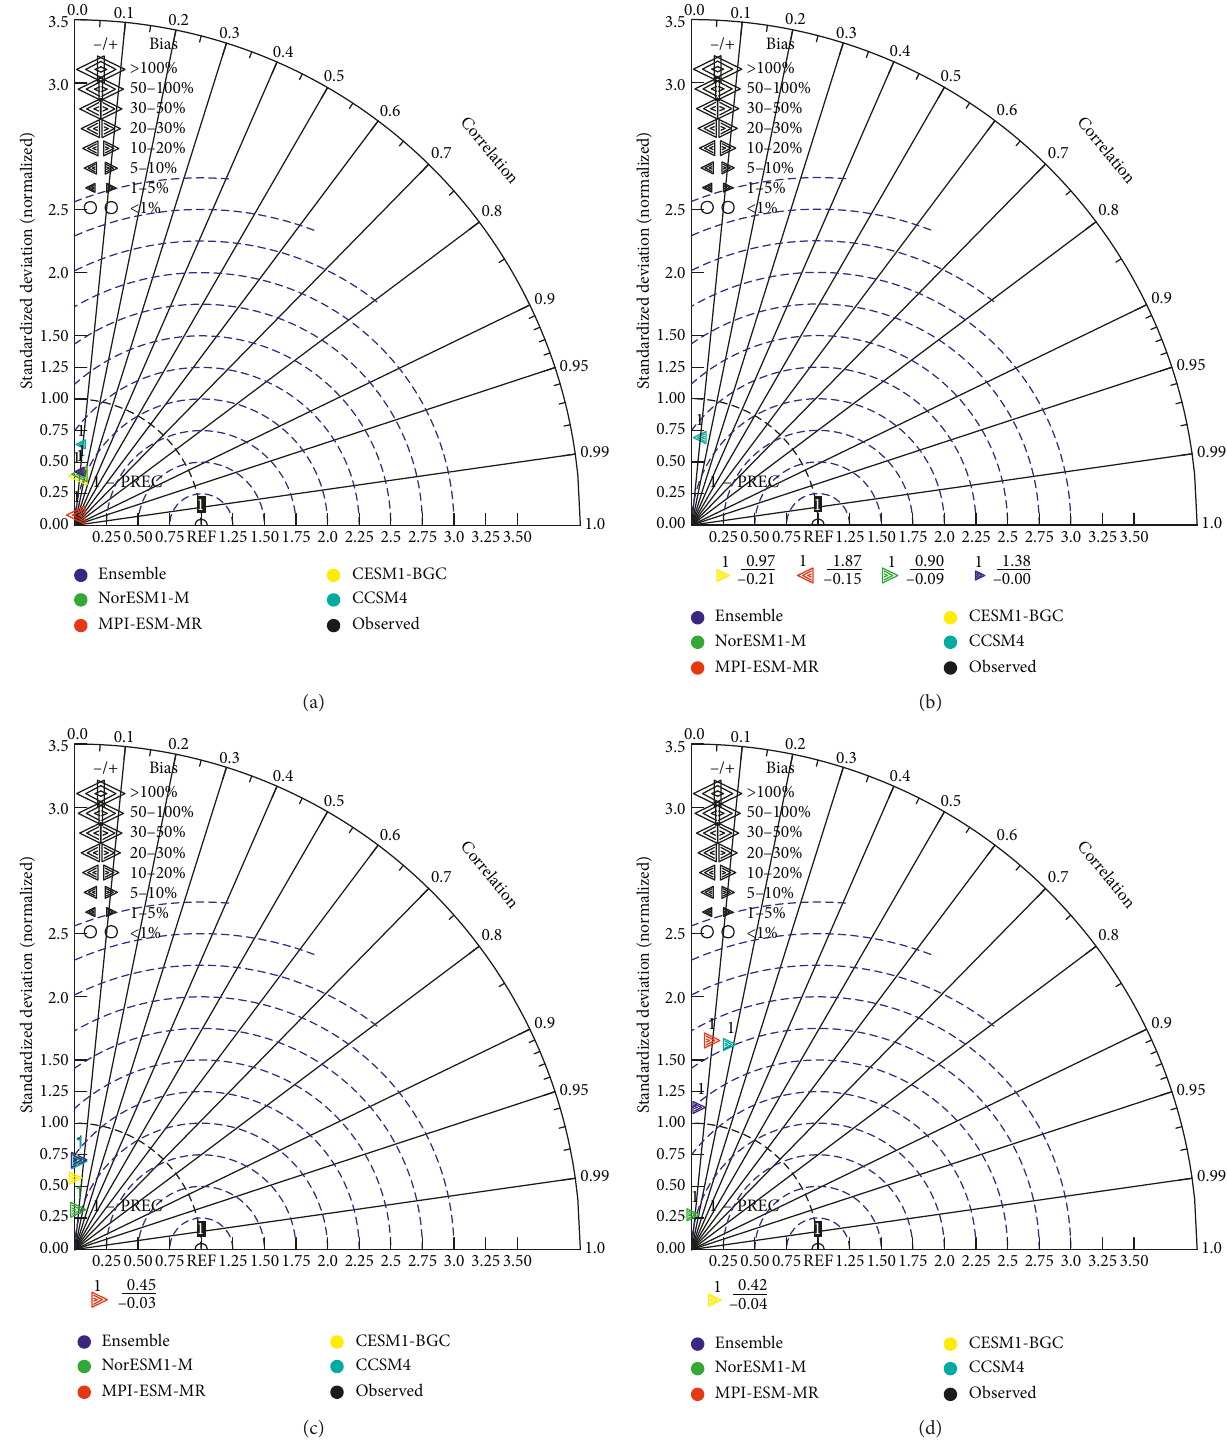
Figure 10: Taylor diagram for the Guinea Coast showing the normalized standard deviation, the correlation, and the RMSE representing the variability, pattern, and errors, respectively, within the models and the reference data: DJF (a); MAM (b); JJA (c); SON